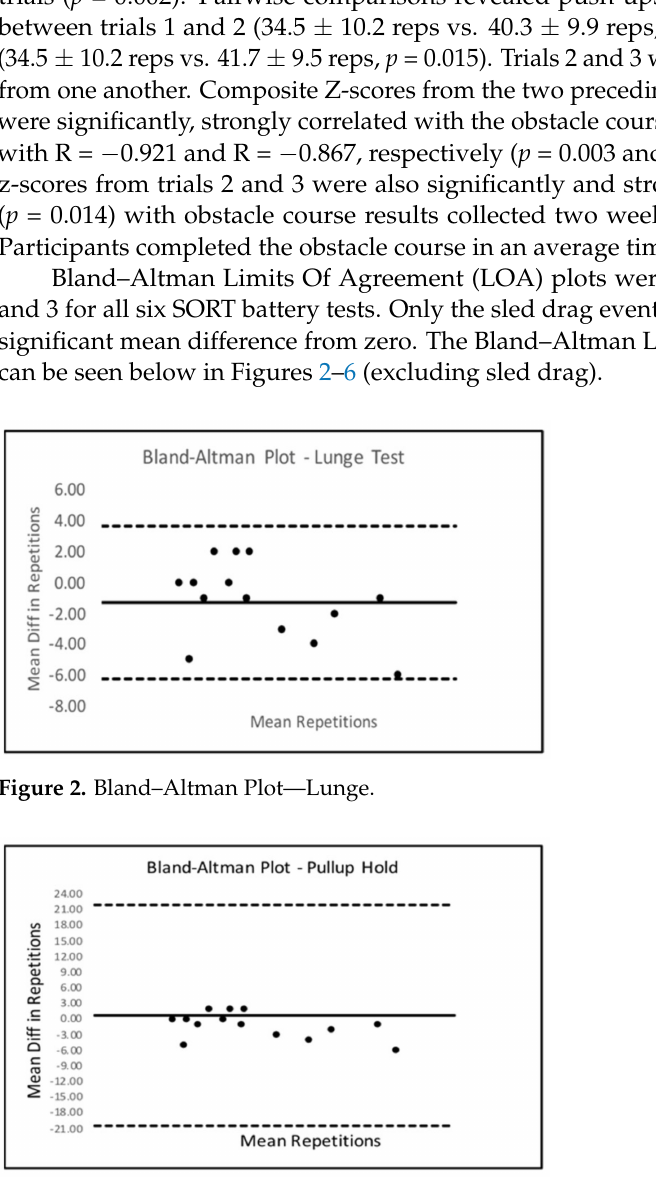
Figure 3. Bland–Altman